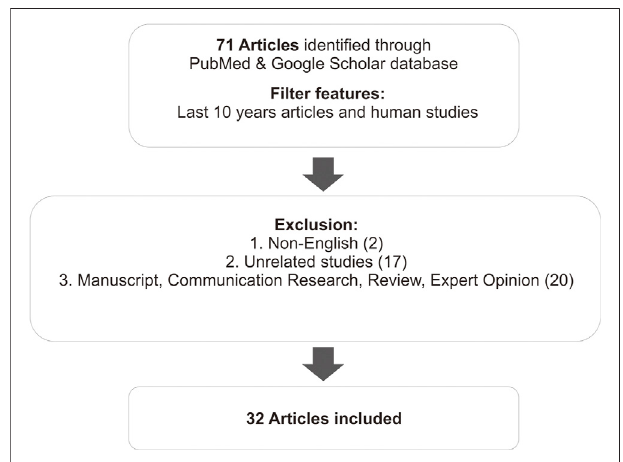
FIGURE 1 | Research methodology fl